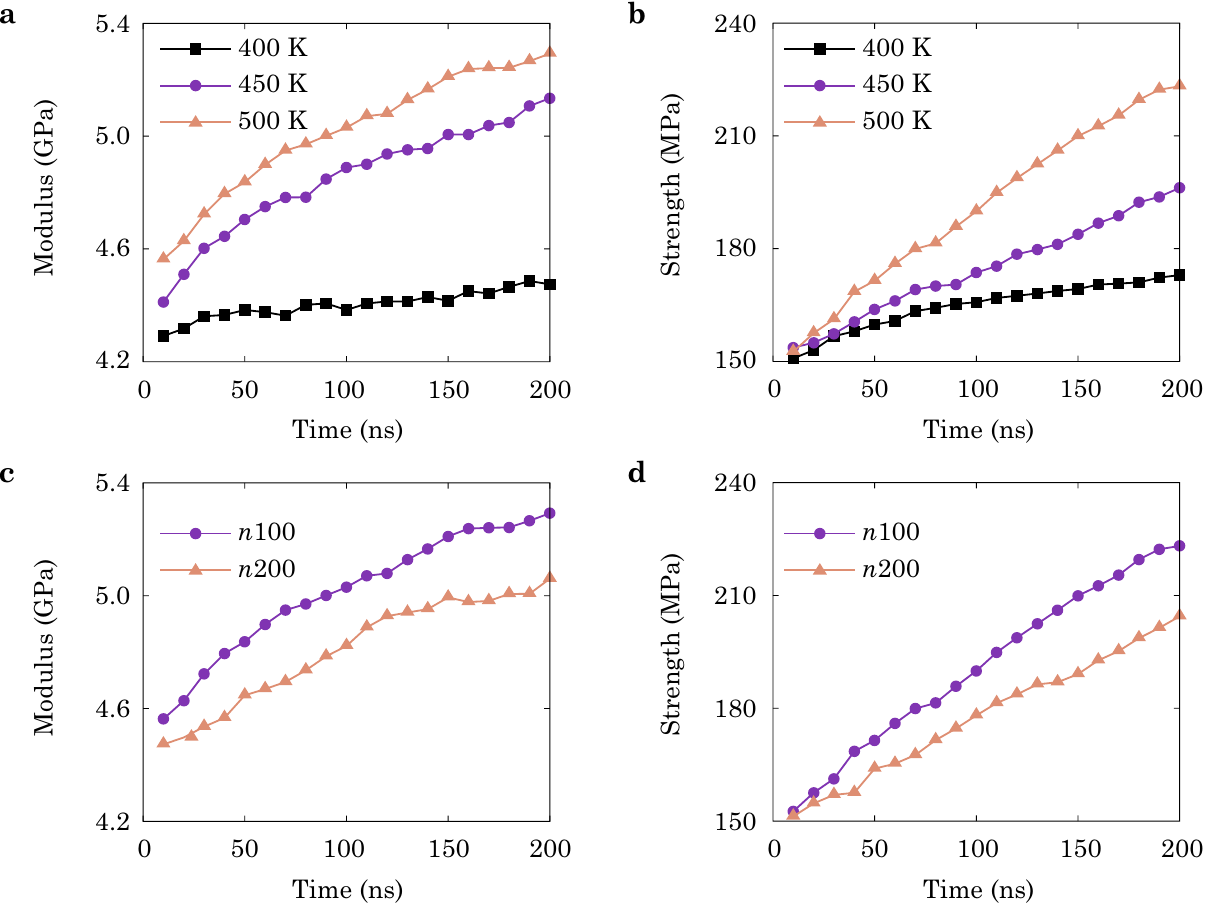
Figure 5. ( a ) Young’s modulus and ( b ) the tensile strength of the fused PE/PP interfaces plotted against the fusion time at different temperature ( T = 400, 450, 500 K) in the CGMD simulations. ( c ) Young’s modulus and ( d ) the tensile strength of fused PE/PP interfaces plotted against the fusion time with different chain lengths, n 100 and n 200 in the CGMD simulations. The temperature is controlled at 500 K for data shown in ( c ) and ( d